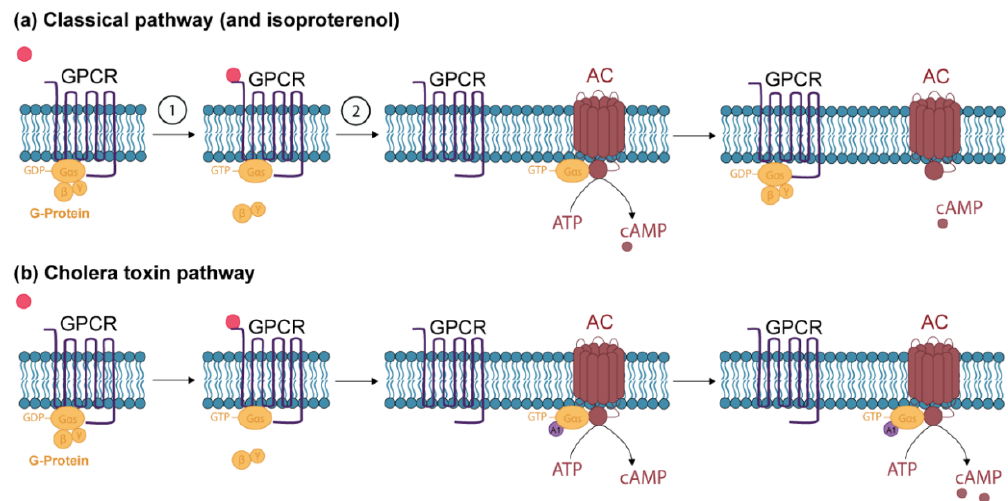
Figure 1. The cAMP signaling pathways. ( a ) 1: The first messenger (red) binds to the G protein-coupled receptor (GPCR). The receptor then changes conformation, leading to the replacement of GDP by GTP on the α subunit of the G protein and inducing the subsequent release of the α subunit from the β and γ subunits of the G protein [21,31]. 2: The α subunit binds to the catalytic domain of adenylate cyclase (AC). The α subunit can have inhibitory ( α i ) or stimulating ( α s ) properties, which will lead to the inhibition or stimulation of AC [16,32]. The activated AC will convert ATP into cAMP. Isoproterenol induces the conversion of ATP to cAMP following the classical pathway ( b ) The A1 peptide of cholera toxin (CT) (purple) binds to the complex composed of the GTP- α subunit of the G protein and AC and prevents the G protein from cleaving GTP to GDP, leading to a tremendous increase in cAMP levels [30].